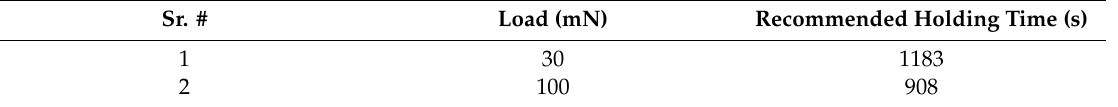
Table 2. Recommended holding times for UHMWPE for the two di ff erent peak